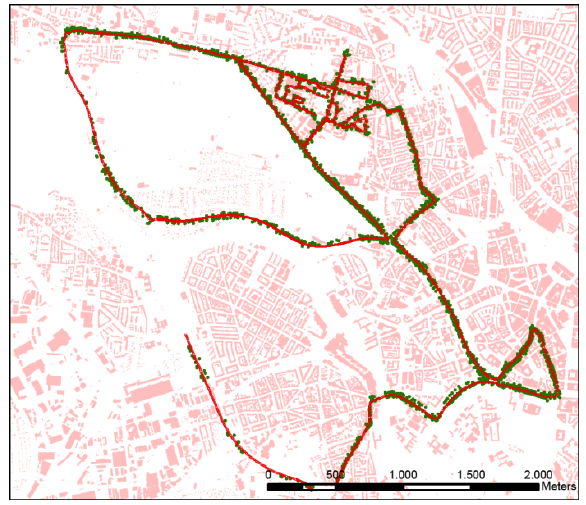
Figure 1. Trajectory (red) and extracted pole-like objects (green) which are used as reference